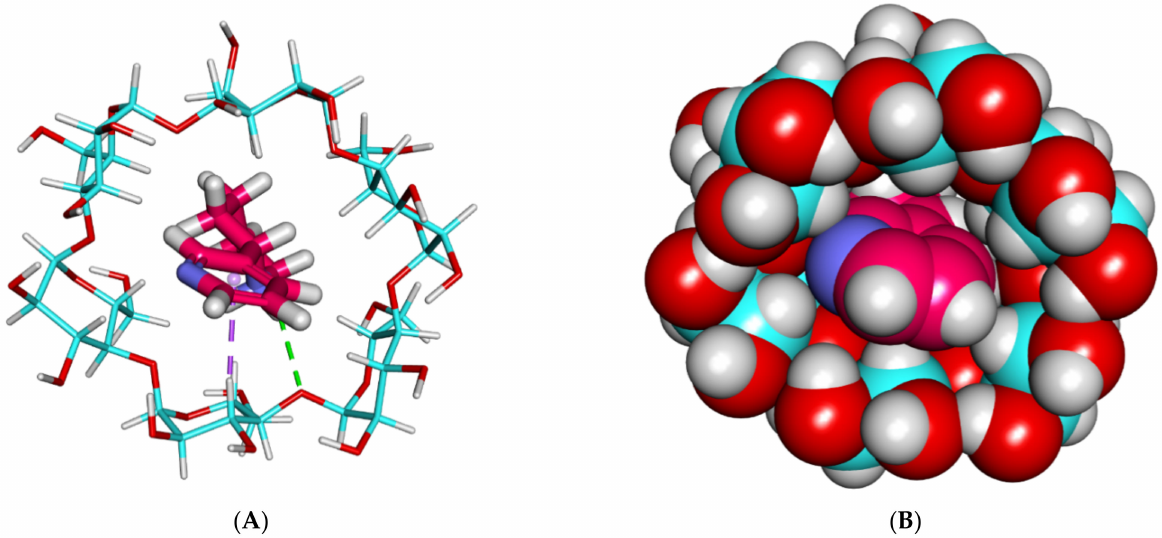
Figure 2. The best-ranked docking poses of anabasine with α CD, top view, as sticks ( A ), and CPK ( B ). Secondly, the anabasine alkaloid exhibited a much better binding mode with β and γ CD, where anabasine afforded a high binding score with the β of − 21.48 kcal/mol, respectively. The binding mode of the anabasine alkaloid against β CD formed several vital interac- tions. The piperidine ring of the anabasine alkaloid formed two hydrogen bonds with the various OHs of the glucose moieties. The pyridine ring of the anabasine alkaloid formed one hydrogen bond with the OH of the glucose subunits (Figures 3 and